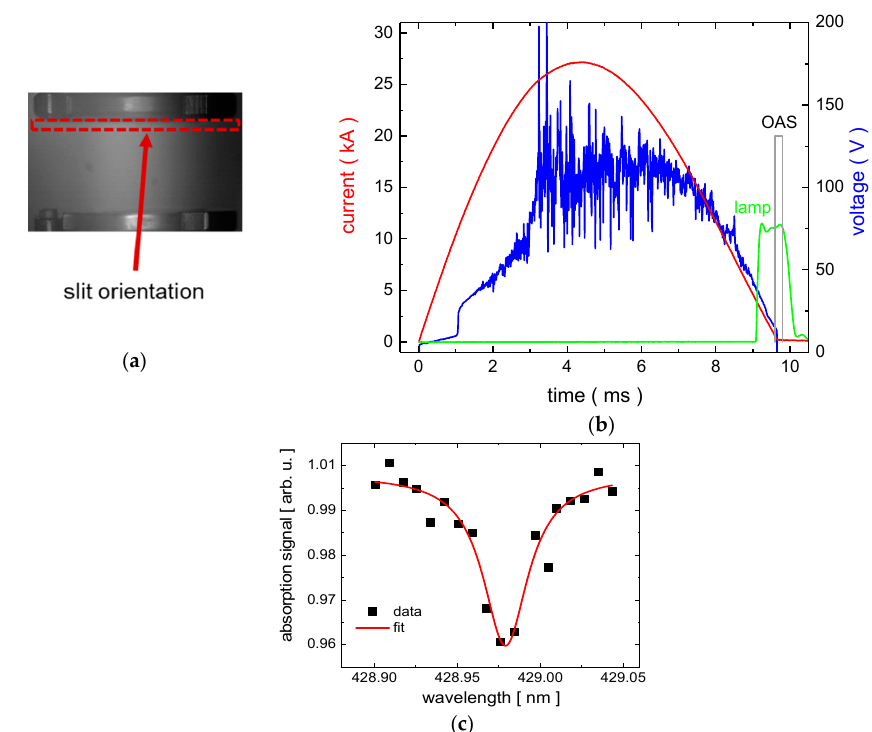
Figure 5. ( a ) Position of spectrograph slit for absorption spectra acquisition. Slit width was 50 µm; distance to the anode was about 1 mm. ( b ) Temporal evolution of current (red) and voltage (blue) along with sequence of control signals during the absorption spectroscopy measurements: driving current of Xe lamp (green) and exposure signal for spectrum acquisition (grey). ( c ) Example of Cr I 428.97 nm line fit procedure.